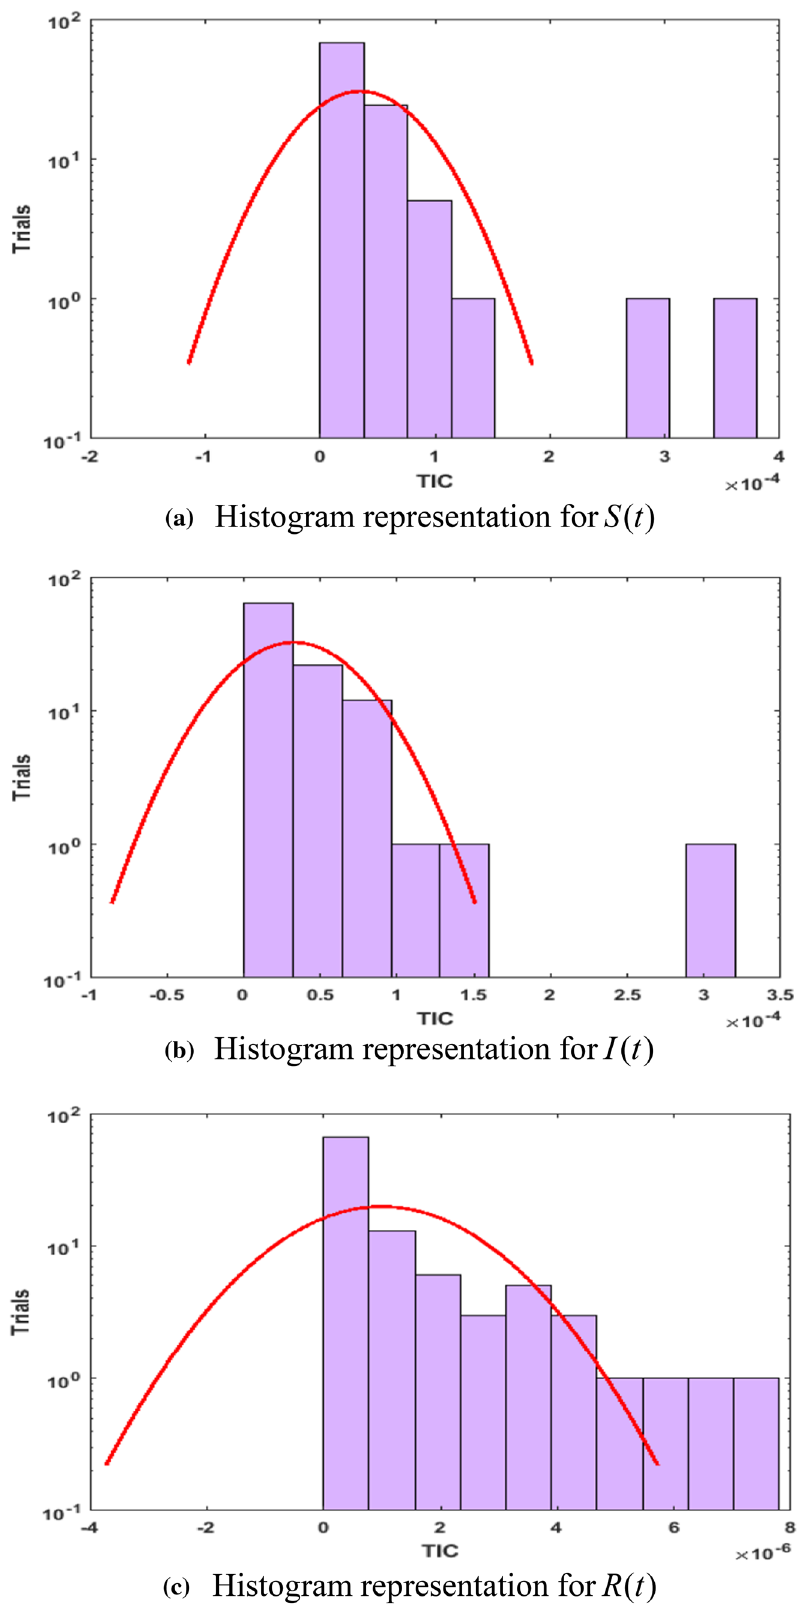
Fig. 7 Histograms depiction of TIC for S ( t ), I ( t ) , R ( t ) using